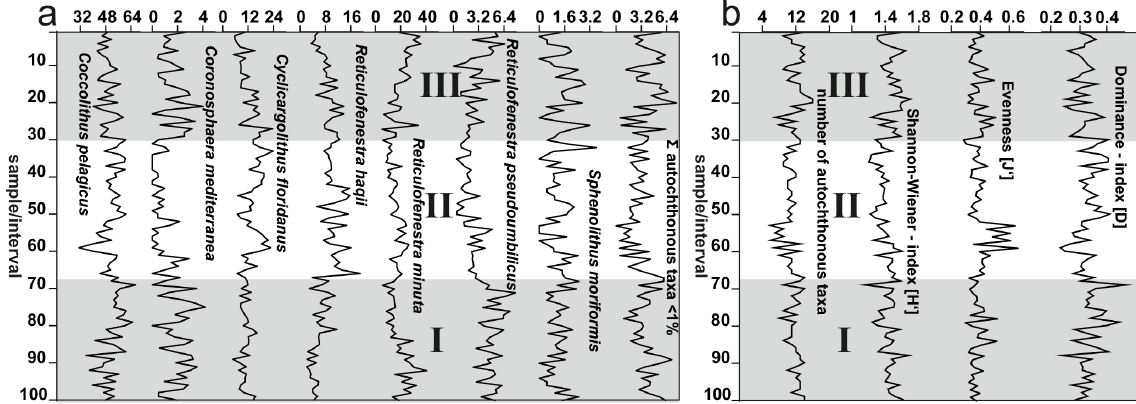
Figure 5. Relative abundances of autochthonous coccolith taxa > 1% as well as the abundance of autochthonous taxa < 1%, normalized to 100%, within each sample of the high-resolution section (a) . Diversity indices show the amount of autochthonous taxa, the Shannon–Wiener index, species evenness, and the dominance index of the studied samples (b) . The three intervals (I–III) show the depositional episodes defined by visual evaluation of the gathered data